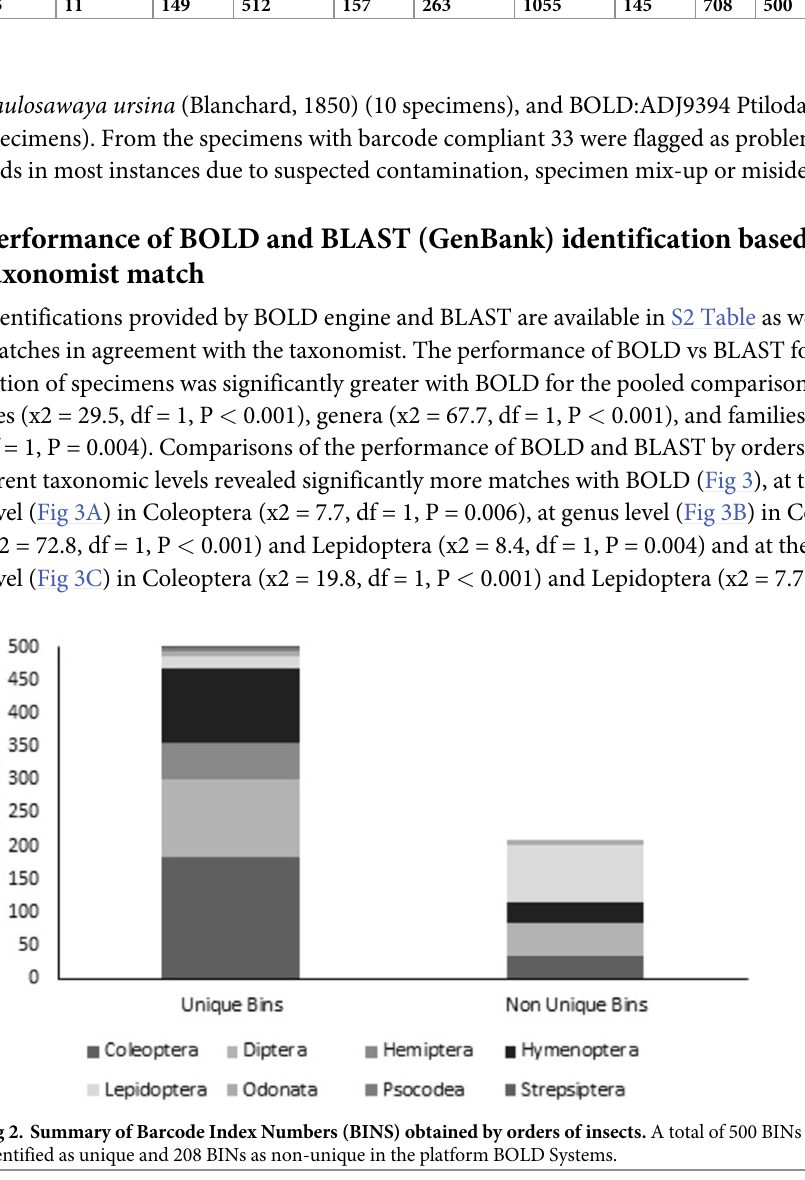
Fig 2. Summary of Barcode Index Numbers (BINS) obtained by orders of insects. A total of 500 BINs were identified as unique and 208 BINs as non-unique in the platform BOLD Systems.